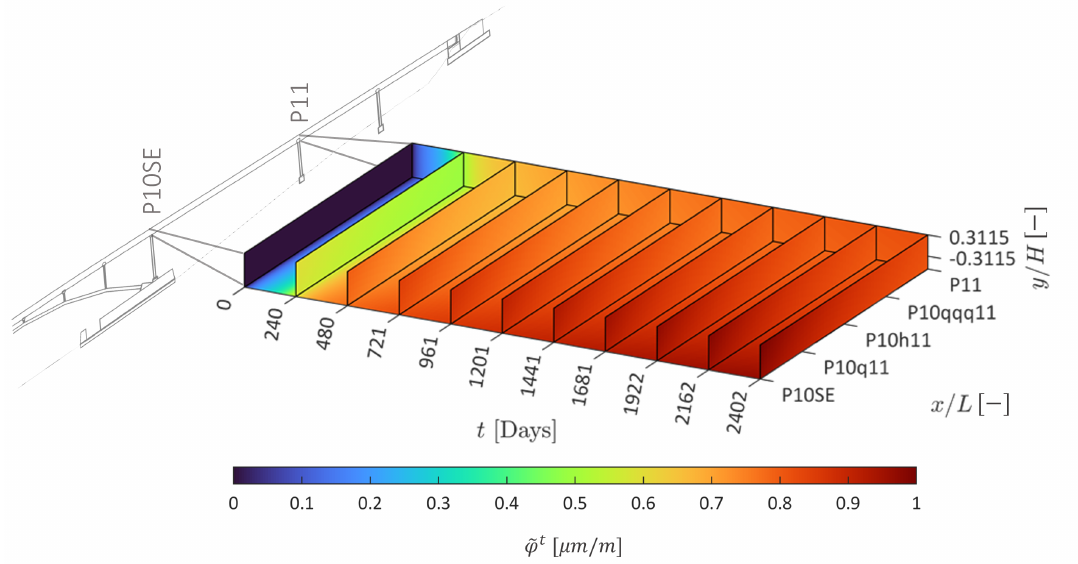
Figure 12. Evolution of the normalized rheological